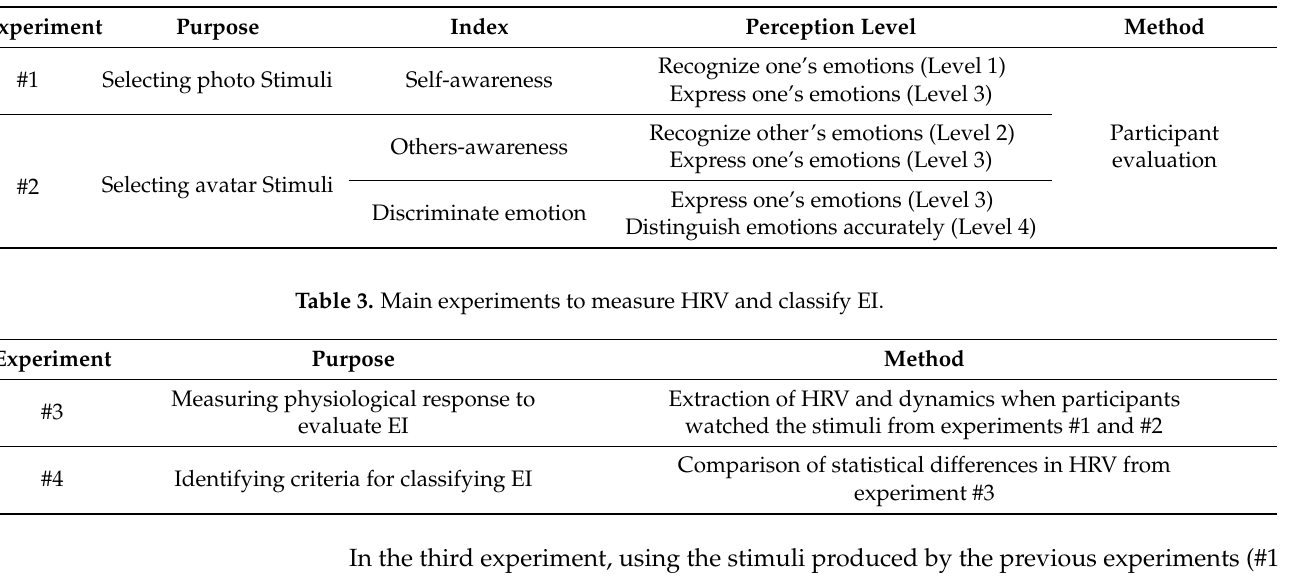
Table 2. Two experiments to produce stimuli (photo and avatar) for the latter experiments.